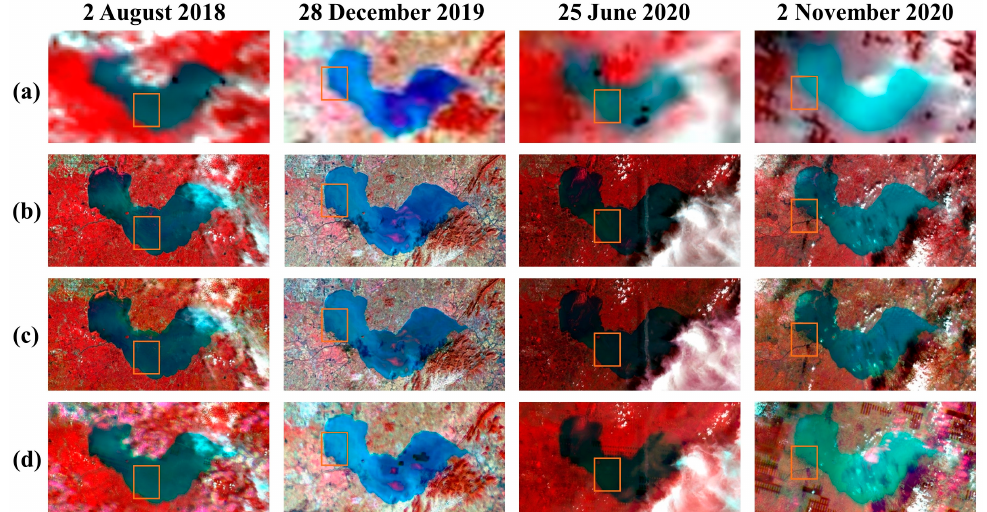
Figure 6. Visualized images in false color for four dates. ( a – d ) The MODIS images, MSI images, fused images without the degradation model, and fused images with the degradation model, re- spectively. The cloudless pixels inside the yellow boxes were selected for quantitative evaluation.